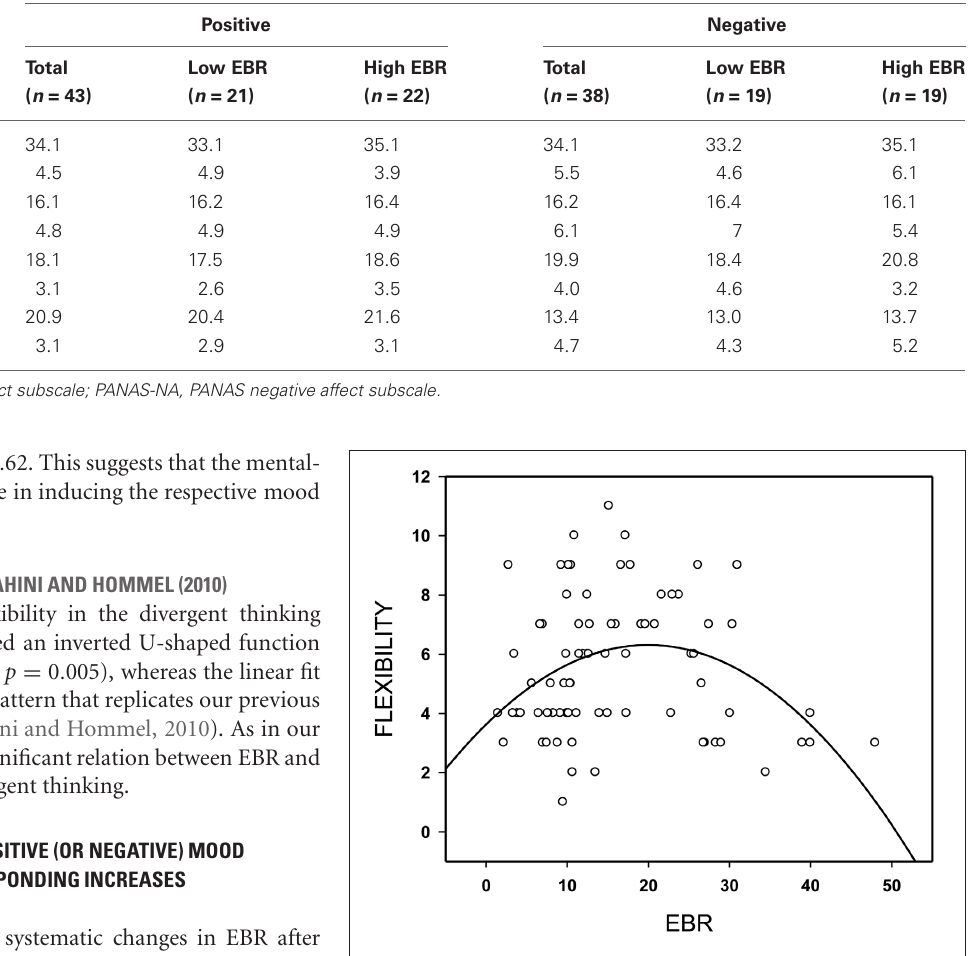
FIGURE 2 | Flexibility in the divergent thinking task as a function of spontaneous eye blink rate (EBR) per min. Regression line for best (quadratic)